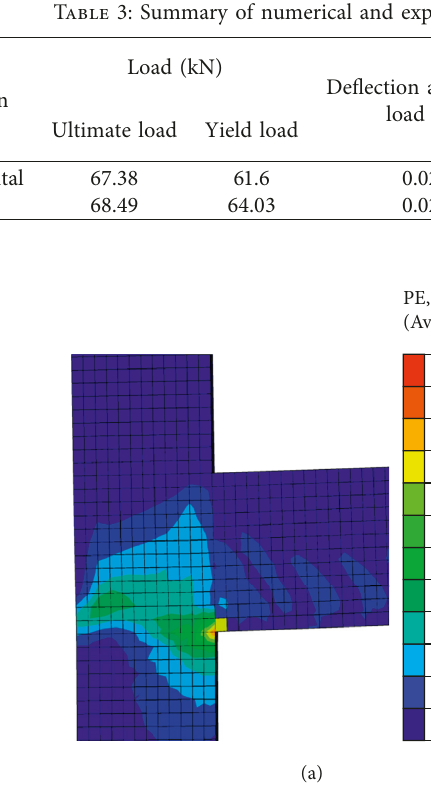
Figure 11: Crack observed at failure load: (a) FEM and (b) experimental test [25].